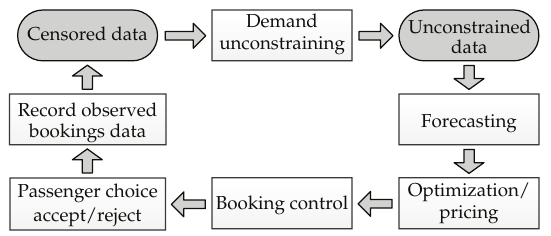
Figure 2: A revenue management process.